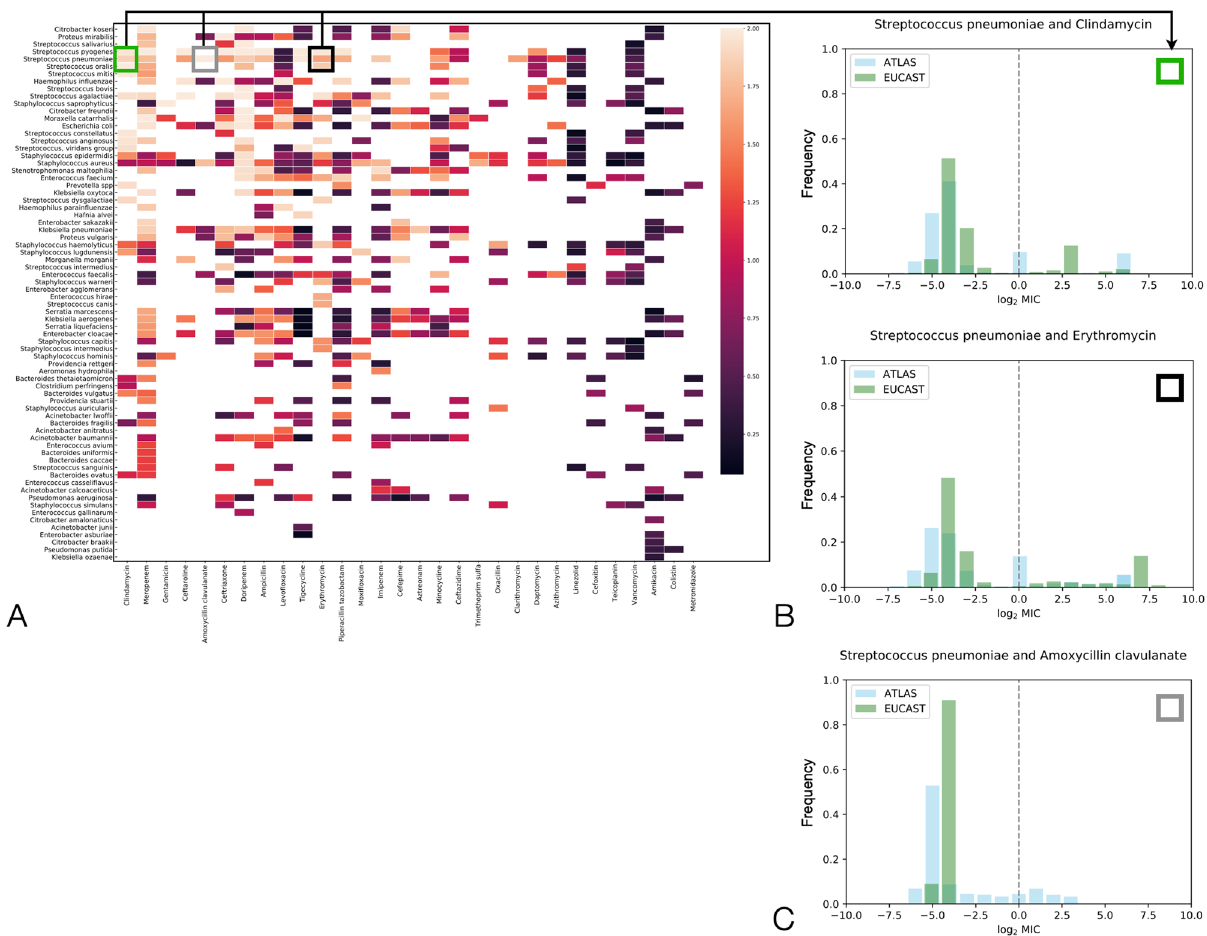
Fig. 2 Comparing ATLAS with MIC histograms from EUCAST: from the worst to best correspondences. A If an MIC (minimal inhibitory concentration) histogram from EUCAST is the vector x and an analogous histogram is determined from ATLAS (by aggregating across all years) and denoted y , this heatmap shows the Euclidean distance ∥ x − y ∥ 2 for each pathogen-antibiotic (PA) pair in both databases: squares indicate distances on a colour scale, black denotes close agreement and pink denotes poor agreement, white shows no comparison can be made. Axis labels are ordered whereby the biggest ATLAS-EUCAST disagreements are generally found leftmost and uppermost. B Two MIC histograms are shown whereby the open black and green squares superimposed on A highlight S. pneumoniae and clindamycin and erythromycin as having among the biggest disagreements between ATLAS and EUCAST. C The case of S. pneumoniae and amoxycillin clavulanate is one of 10 antibiotic PA pairs for which ATLAS has resistant subpopulations according to CLSI breakpoints, but EUCAST does not (also Supplementary Fig.